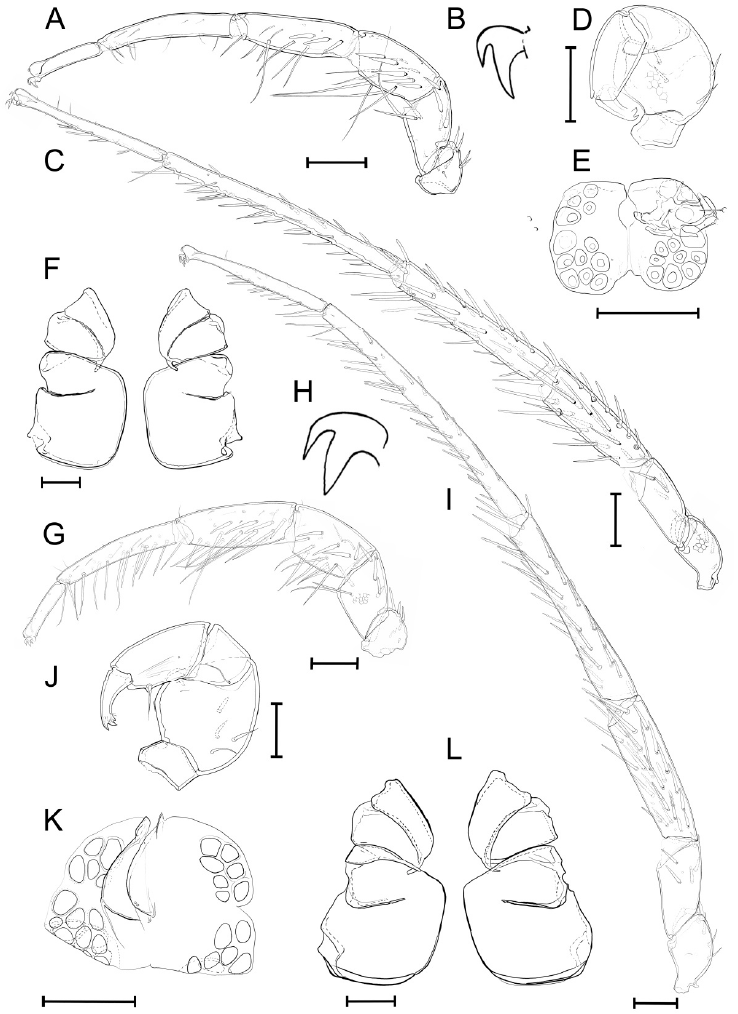
Figure 7. Unionicola ( Myanmaratax ) trapezidens sp. nov. The male, slide RMBH Hyd 388: ( A ) I-L, ( B ) claw of I-L, ( C ) IV-L, ( D ) P, ( E ) genital field, and ( F ) coxal plate. The female, slide RMBH Hyd 388: ( G ) I-L, ( H ) claw of I-L, ( I ) IV-L, ( J ) P, ( K ) genital field, and ( L ) coxal plate. Scale bars = 100 µ m. (Graphics: Yulia E.